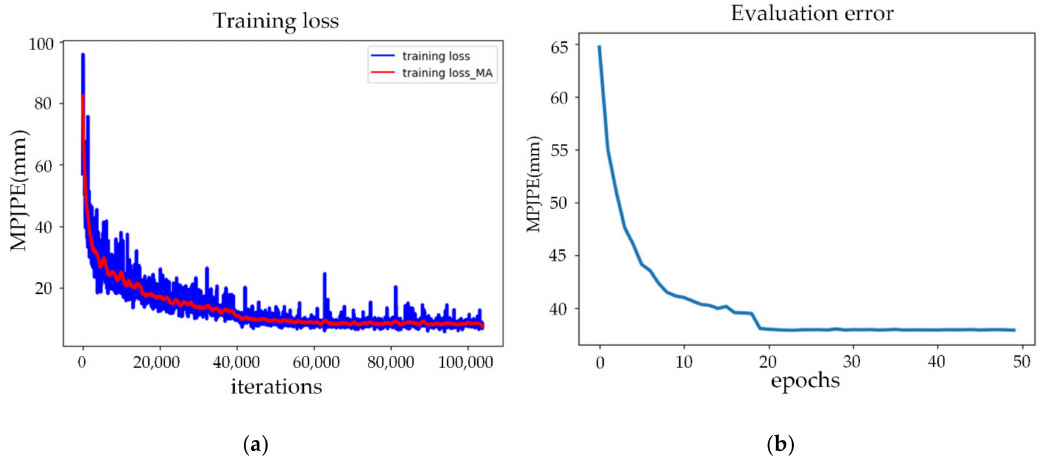
Figure 8. ( a ) The training loss of our network; ( b ) The evaluation loss on the test set.